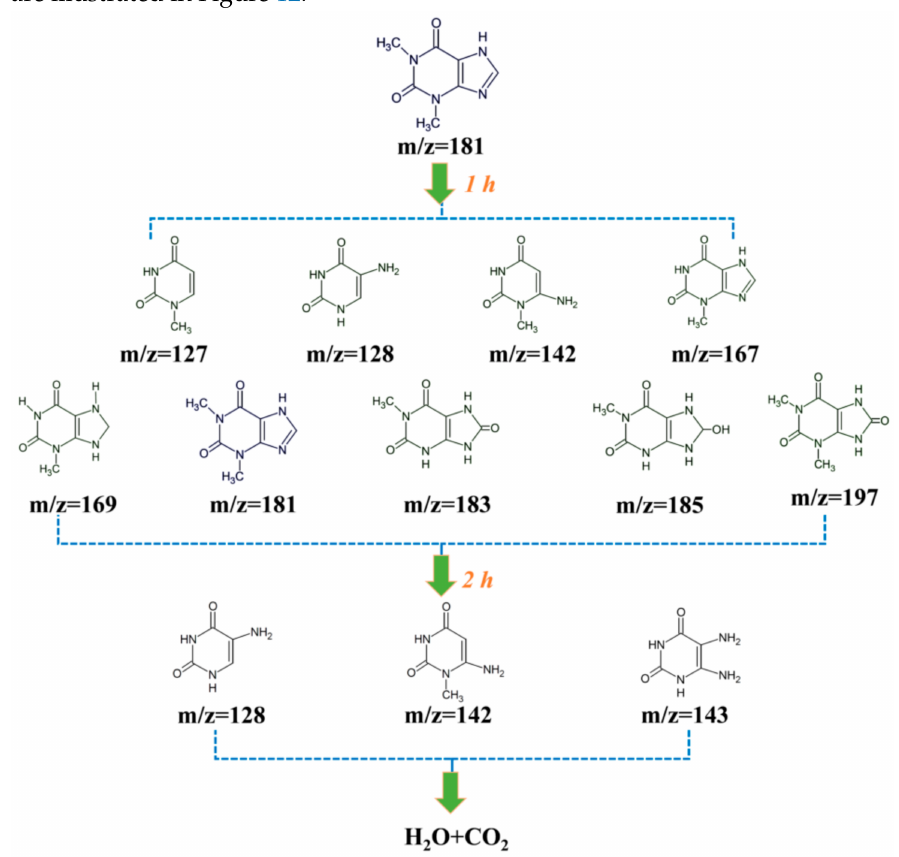
Figure 10. The possible visible light photodegradation pathway of theophylline using